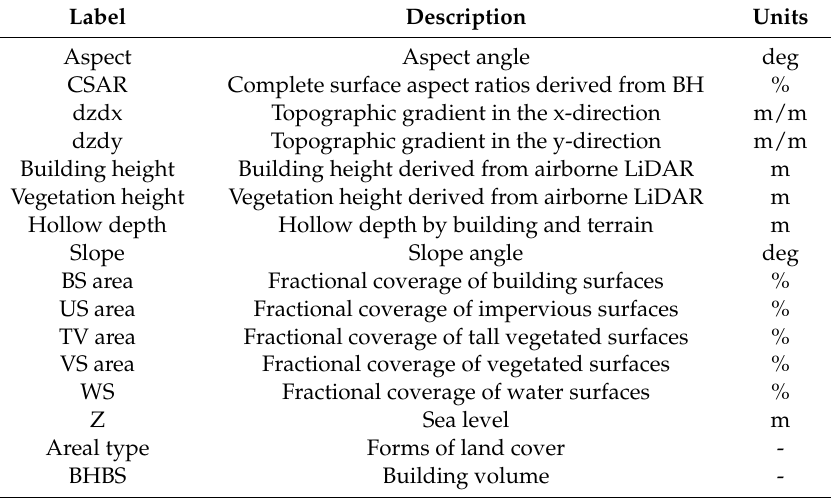
Table 2. Urban surface parameters used for downscaling of air